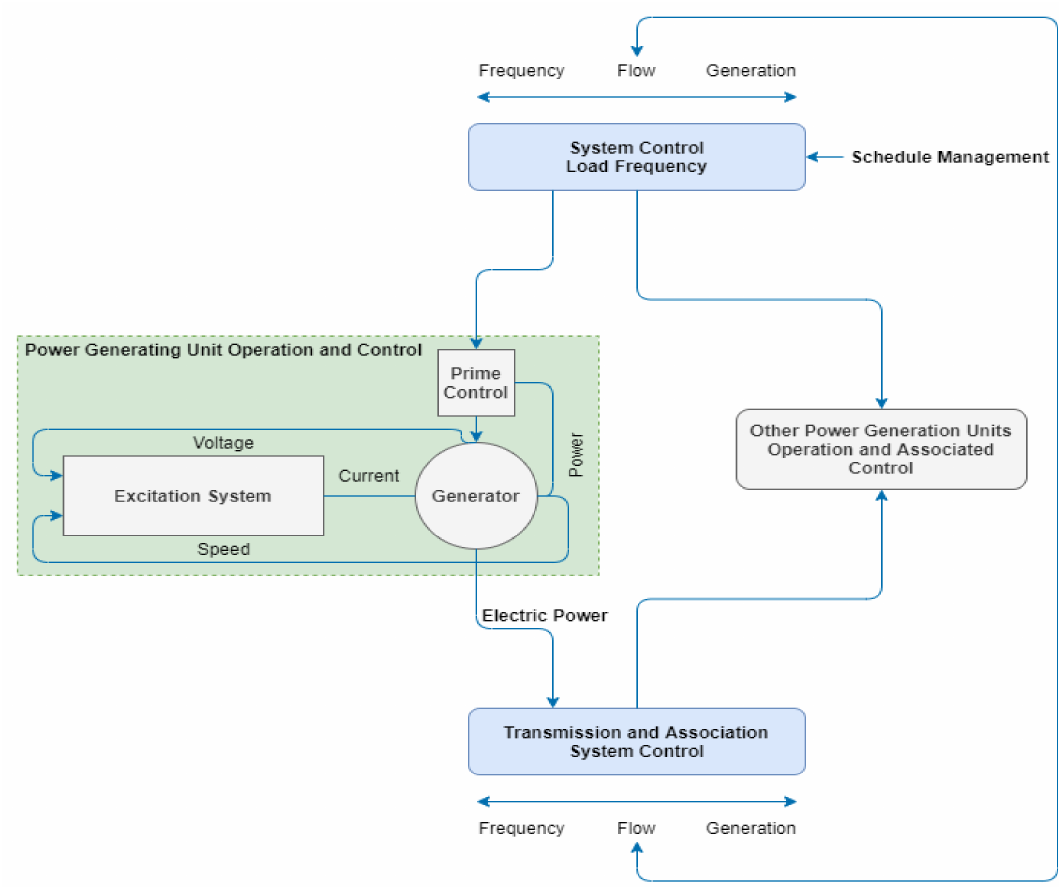
Figure 3. Presented is the working of current renewable power grid systems operation and control